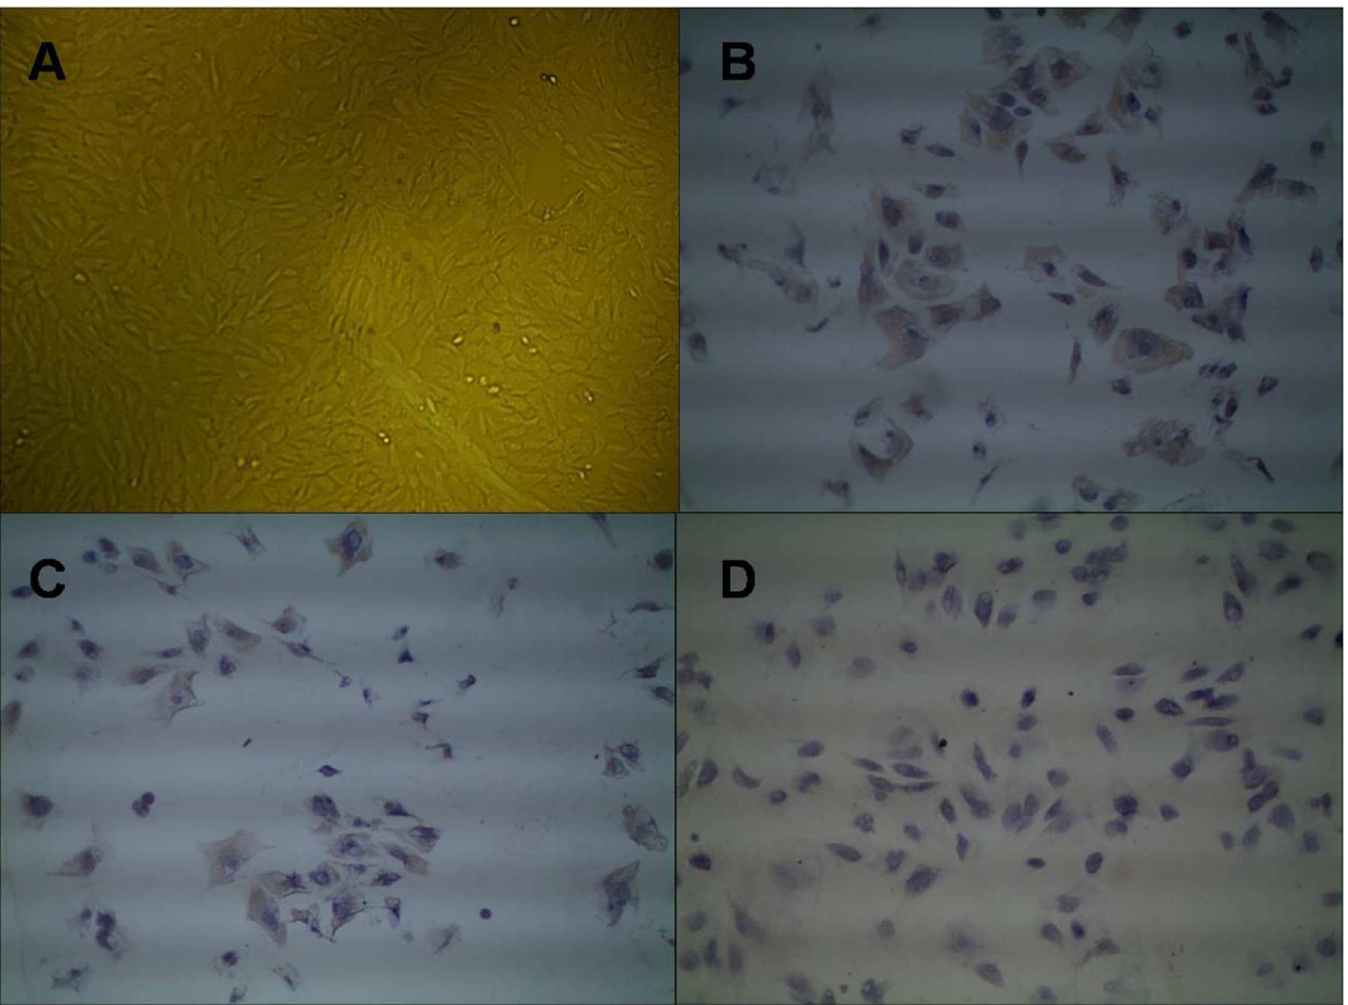
Fig 1. The morphological characteristics and identification of third-generation BMSCs. (A) Third-generation BMSCs ( × 100).(B) Third-generation BMSCs that were CD44-positive ( × 100).(C) Third-generation BMSCs that were CD29-positive ( × 100). (D) Third-generation BMSCs that were CD44-negative ( ×